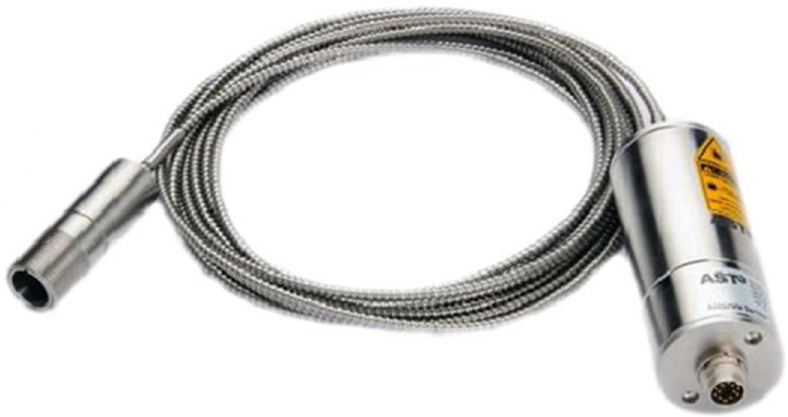
Figure 3. Pyrometer AST 250.